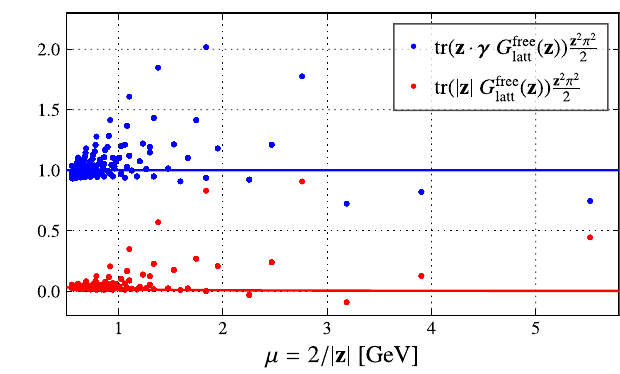
Fig. 3 The relevant triangle diagram, where the two local currents are at t = 0, while the smeared interpolating current for the pion with momentum p is situated at t > 0